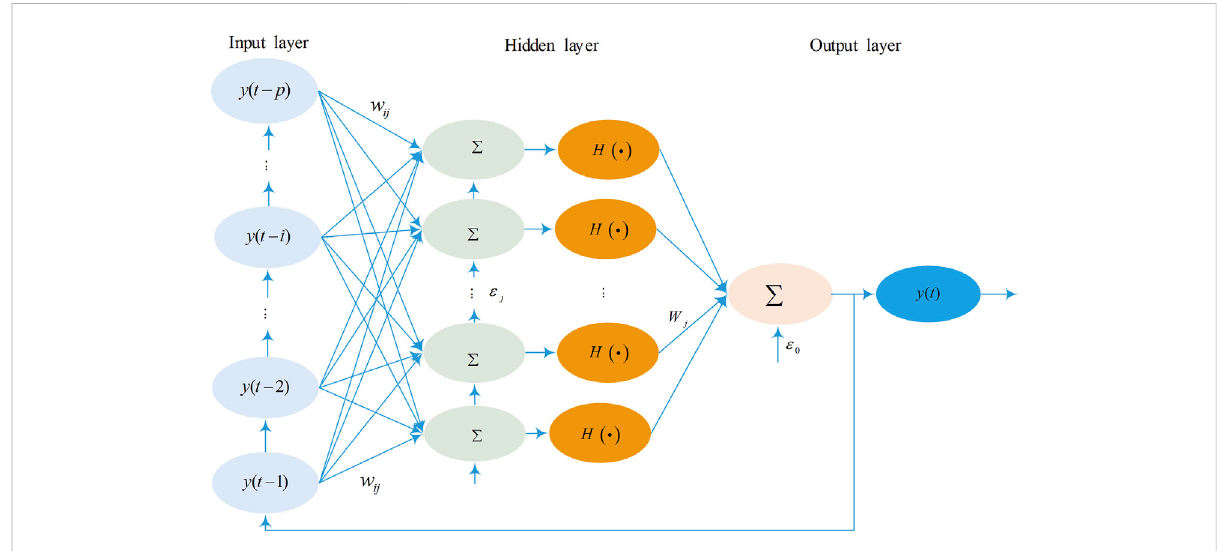
FIGURE 3 The topology structure of the NAR neural network.